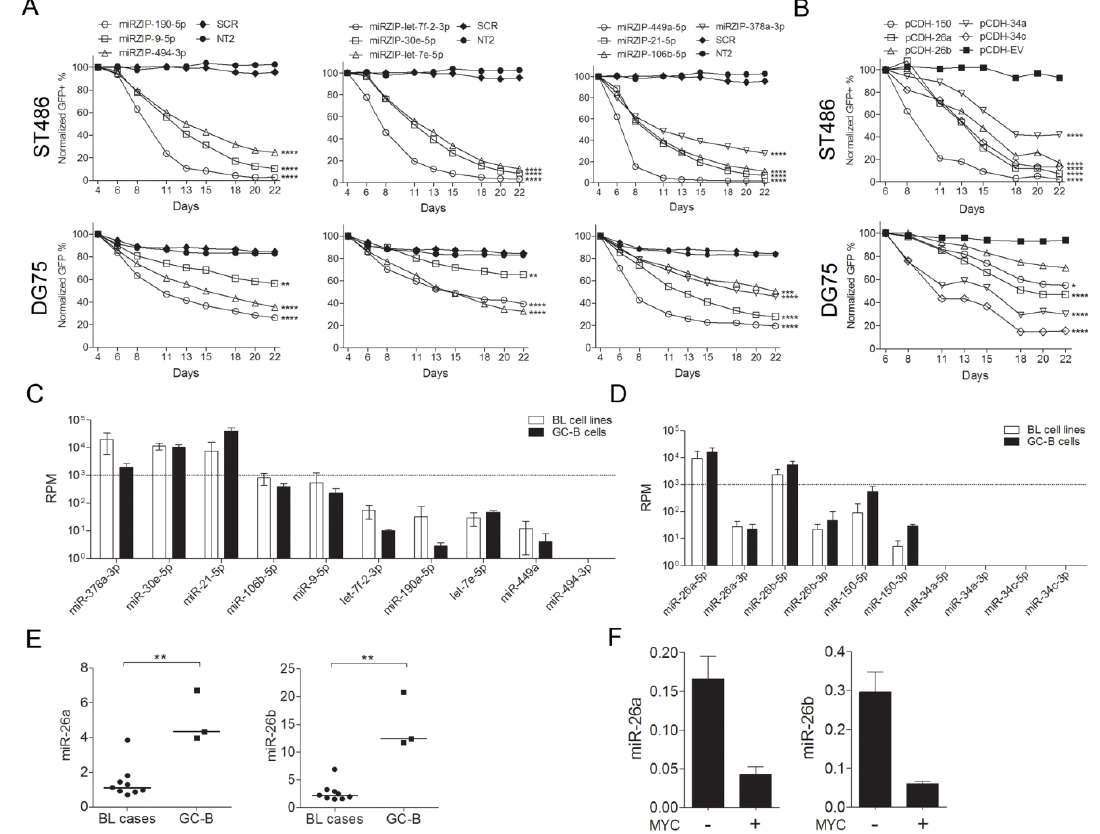
Figure 2. Validation of screening results and selection of miRNAs for functional experiments. Green fluorescent protein (GFP) growth competition assay of individual ( A ) miRNA inhibition and ( B ) miRNA overexpression constructs in ST486 and DG75 cells. The GFP + cell percentage was measured using flow cytometry for 22 days, and the percentage at the first day of measurement was set to 100%. * p < 0.05, ** p < 0.01, *** p < 0.001, and **** p < 0.0001, based on mixed-model analysis. ( C ) Small RNAseq-based expression levels of the miRNA candidates from the miRZip pool and the ( D ) pCDH pool. Shown are the average read counts of 4 BL cell lines (ST486, CA46, DG75, and Ramos) and the average of 3 GC-B cell samples. ( E ) Expression of miR-26a / b-5p in the BL tissue samples and the GC-B cells, and in ( F ) the P493-6 B-cells, with and without MYC expression relative to RNU49 by RT-qPCR. ** p < 0.01 (Mann-Whitney U-test). The lines represent the median of the miRNA